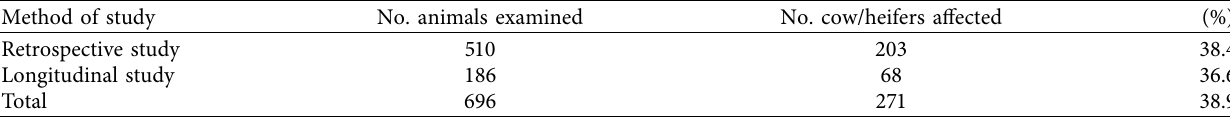
Table 1: Occurrences of repeat breeding in crossbred dairy cattle.